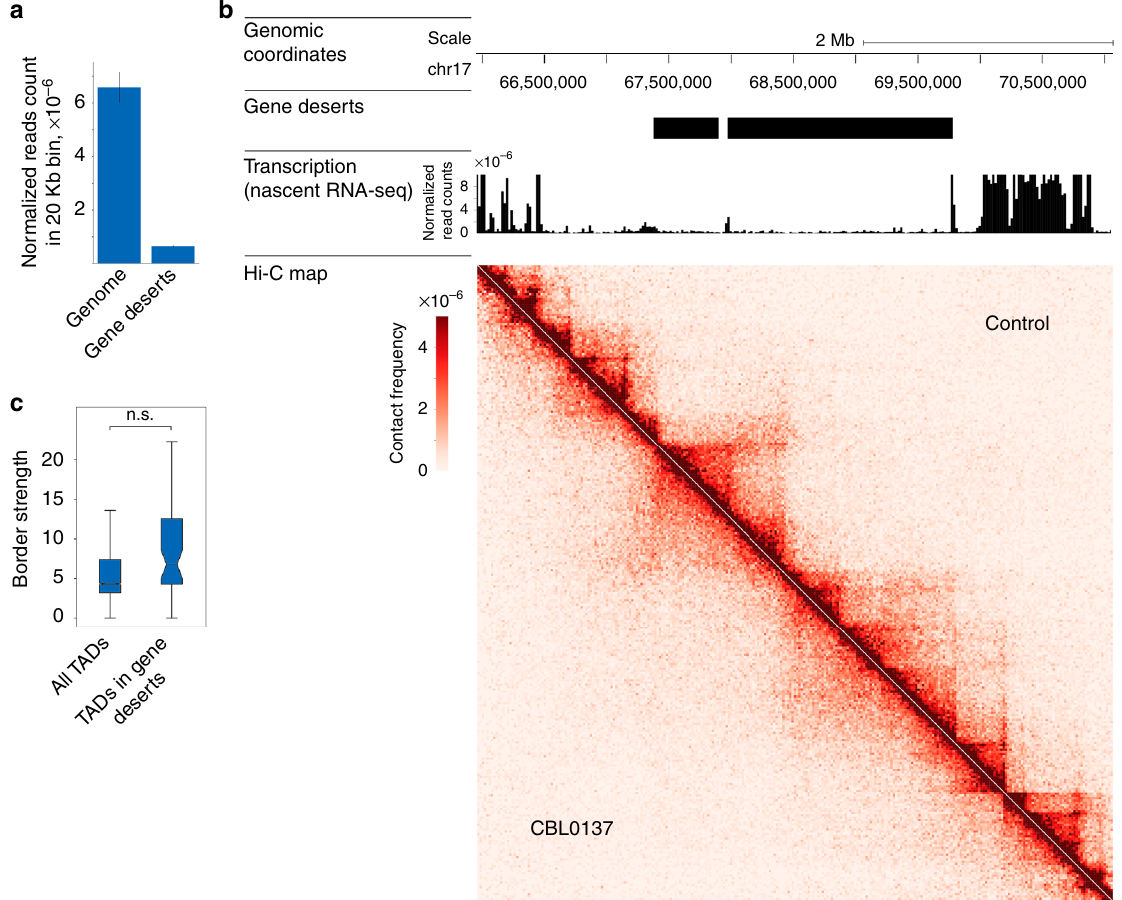
Fig. 5 Effects of CBL0137 on spatial genome organization do not depend on transcription. a Bar plot shows the RNA normalized read count in a 20 kb-long bin calculated from nascent RNA-sequencing data from HT1080 cells. The average data are presented for all genomic bins ( “ genome ” ) and bins located in gene deserts that we de fi ne as extended (> 500 kb) genomic regions lacking known genes. Error bars represent s.e.m. b Genomic segment from chromosome 17 containing a representative extended (~ 2 Mb) gene desert is shown. Corresponding genomic coordinates, mapped gene deserts, transcription levels (normalized reads count) across the region in intact HT1080 cells, and Hi-C maps for control and CBL0137-treated HT1080 cells are indicated. c Box plots showing no difference ( P -value = 0.5137, t -test; n.s. – not signi fi cant) in the TAD border strength calculated for either all TADs mapped in CBL0137-treated HT1080 cells or TADs located in gene deserts. Horizontal lines represent the median; upper and lower ends of boxplot show the upper and lower quartiles, the whiskers indicate the upper and lower fences. Source data of Fig. 5a and c are provided in a Source Data fi